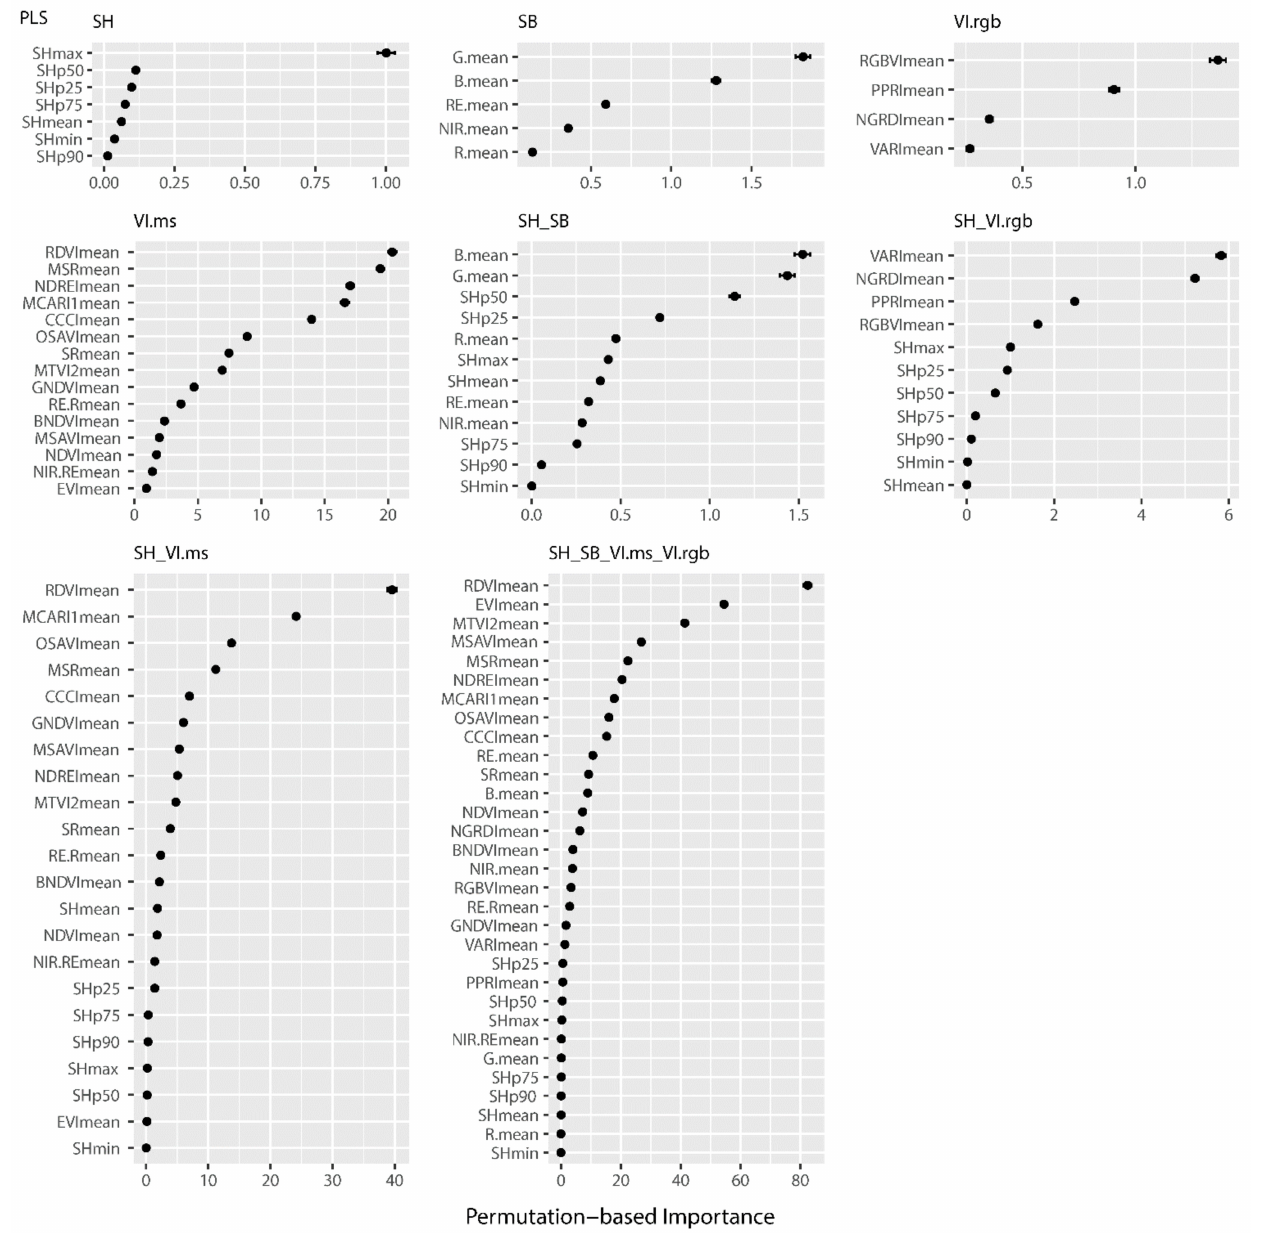
Figure A4. VIP of N% estimation with